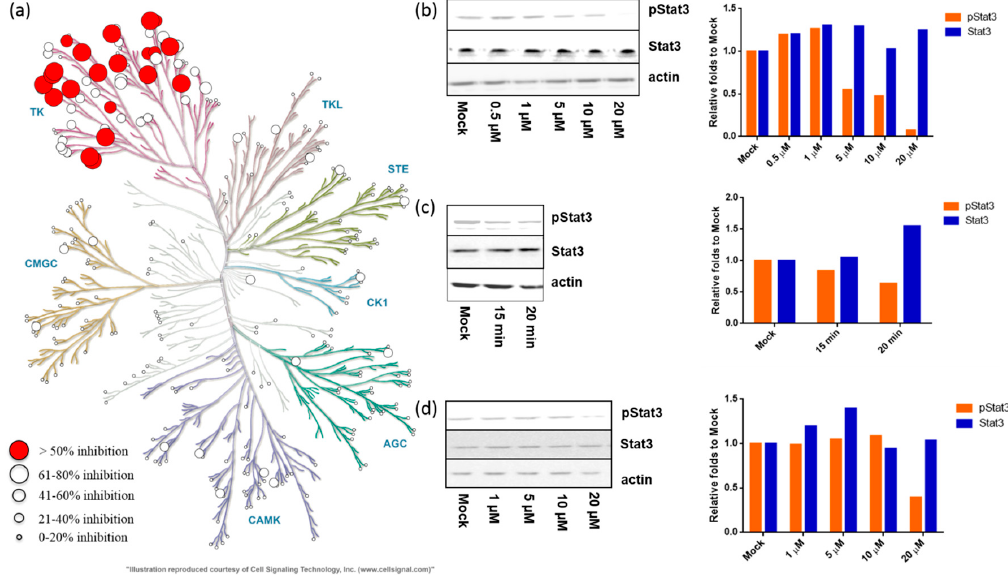
Figure 2. ( a ) Kinase profiling of meisoindigo at 20 µ M against 300 human kinases. Circles show inhibited kinases, the size indicates the strength of inhibition. Kinases inhibited more than 50% are marked red including only tyrosine kinases (TKs). The graphic was generated using KinMap beta developed by BioMedX; ( b ) Meisoindigo inhibited Stat3 activation in HeLa cells in a dose-dependent manner. HeLa cells were incubated with meisoindigo for 30 min. The whole cell lysate was used for immunoblot. Specific antibodies against Stat3 and phospho-Stat3 (Y705) were applied. β -actin served as loading control and 0.1% DMSO as mock; ( c ) Meisoindigo inhibited Stat3 activation in HeLa cells in a time-dependent manner. Cells were treated at 5 µ M as indicated and immunoblot was performed; ( d ) Meisoindigo inhibited Stat3 activation in JoPaca-1 cells in a dose-dependent manner. JoPaca-1 cells were treated for 2 h as indicated and immunoblot was